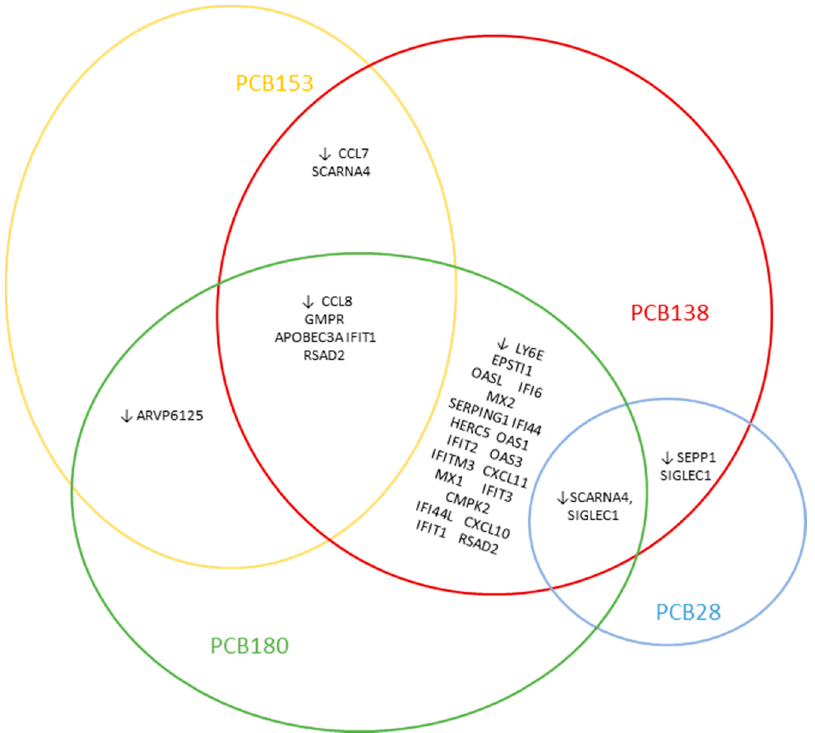
Figure 3. Commonly downregulated genes by single PCB congeners. PCB 180 and 138 contained most commonly downregulated genes. No genes were commonly upregulated.